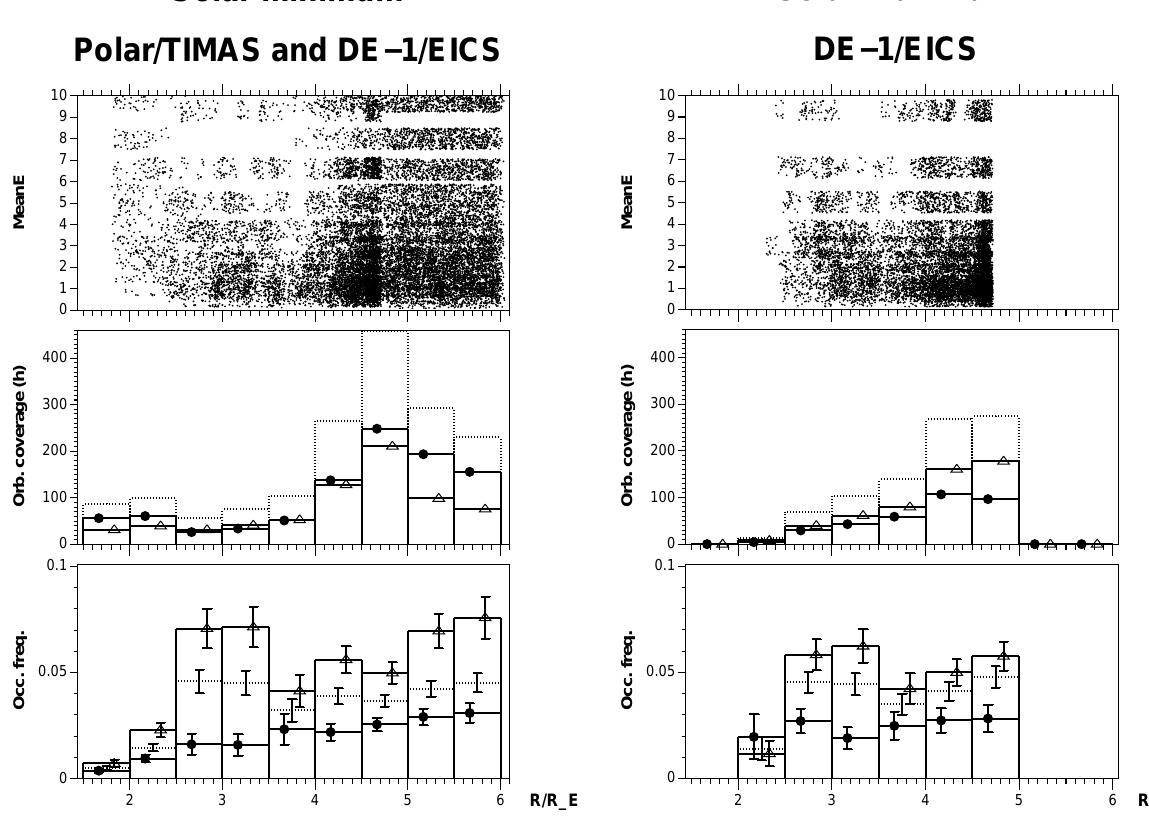
Fig. 5. Same as Fig. 3, but separated for solar minimum (left) and solar maximum years (right). All nightside MLT sectors with both sunlit and darkness conditions are included, and the ILAT range is